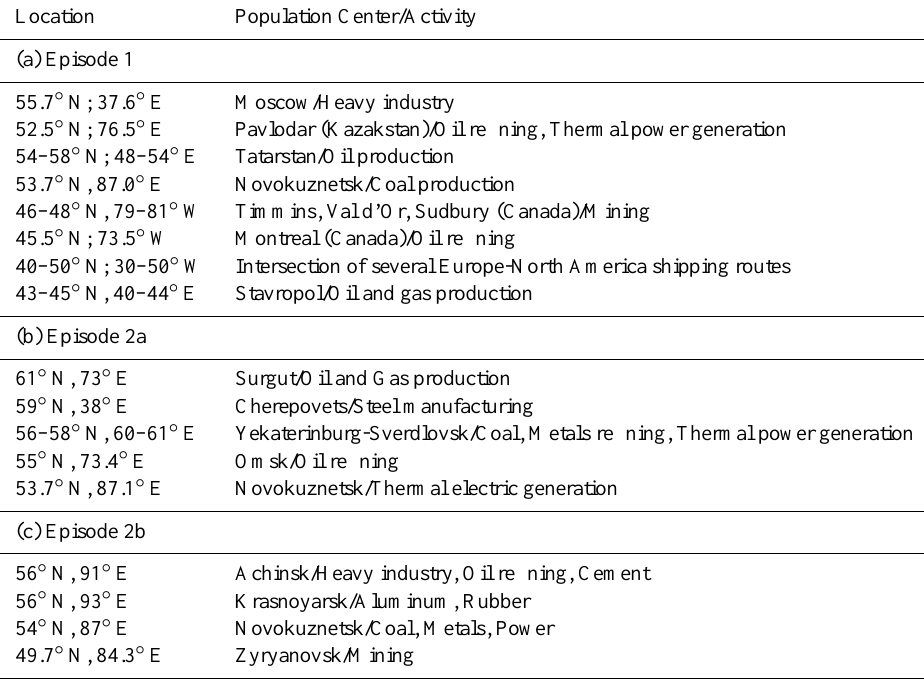
Table 1. Locations and Activities associated with the high source contributions responsible for episodes 1, 2a and 2b.